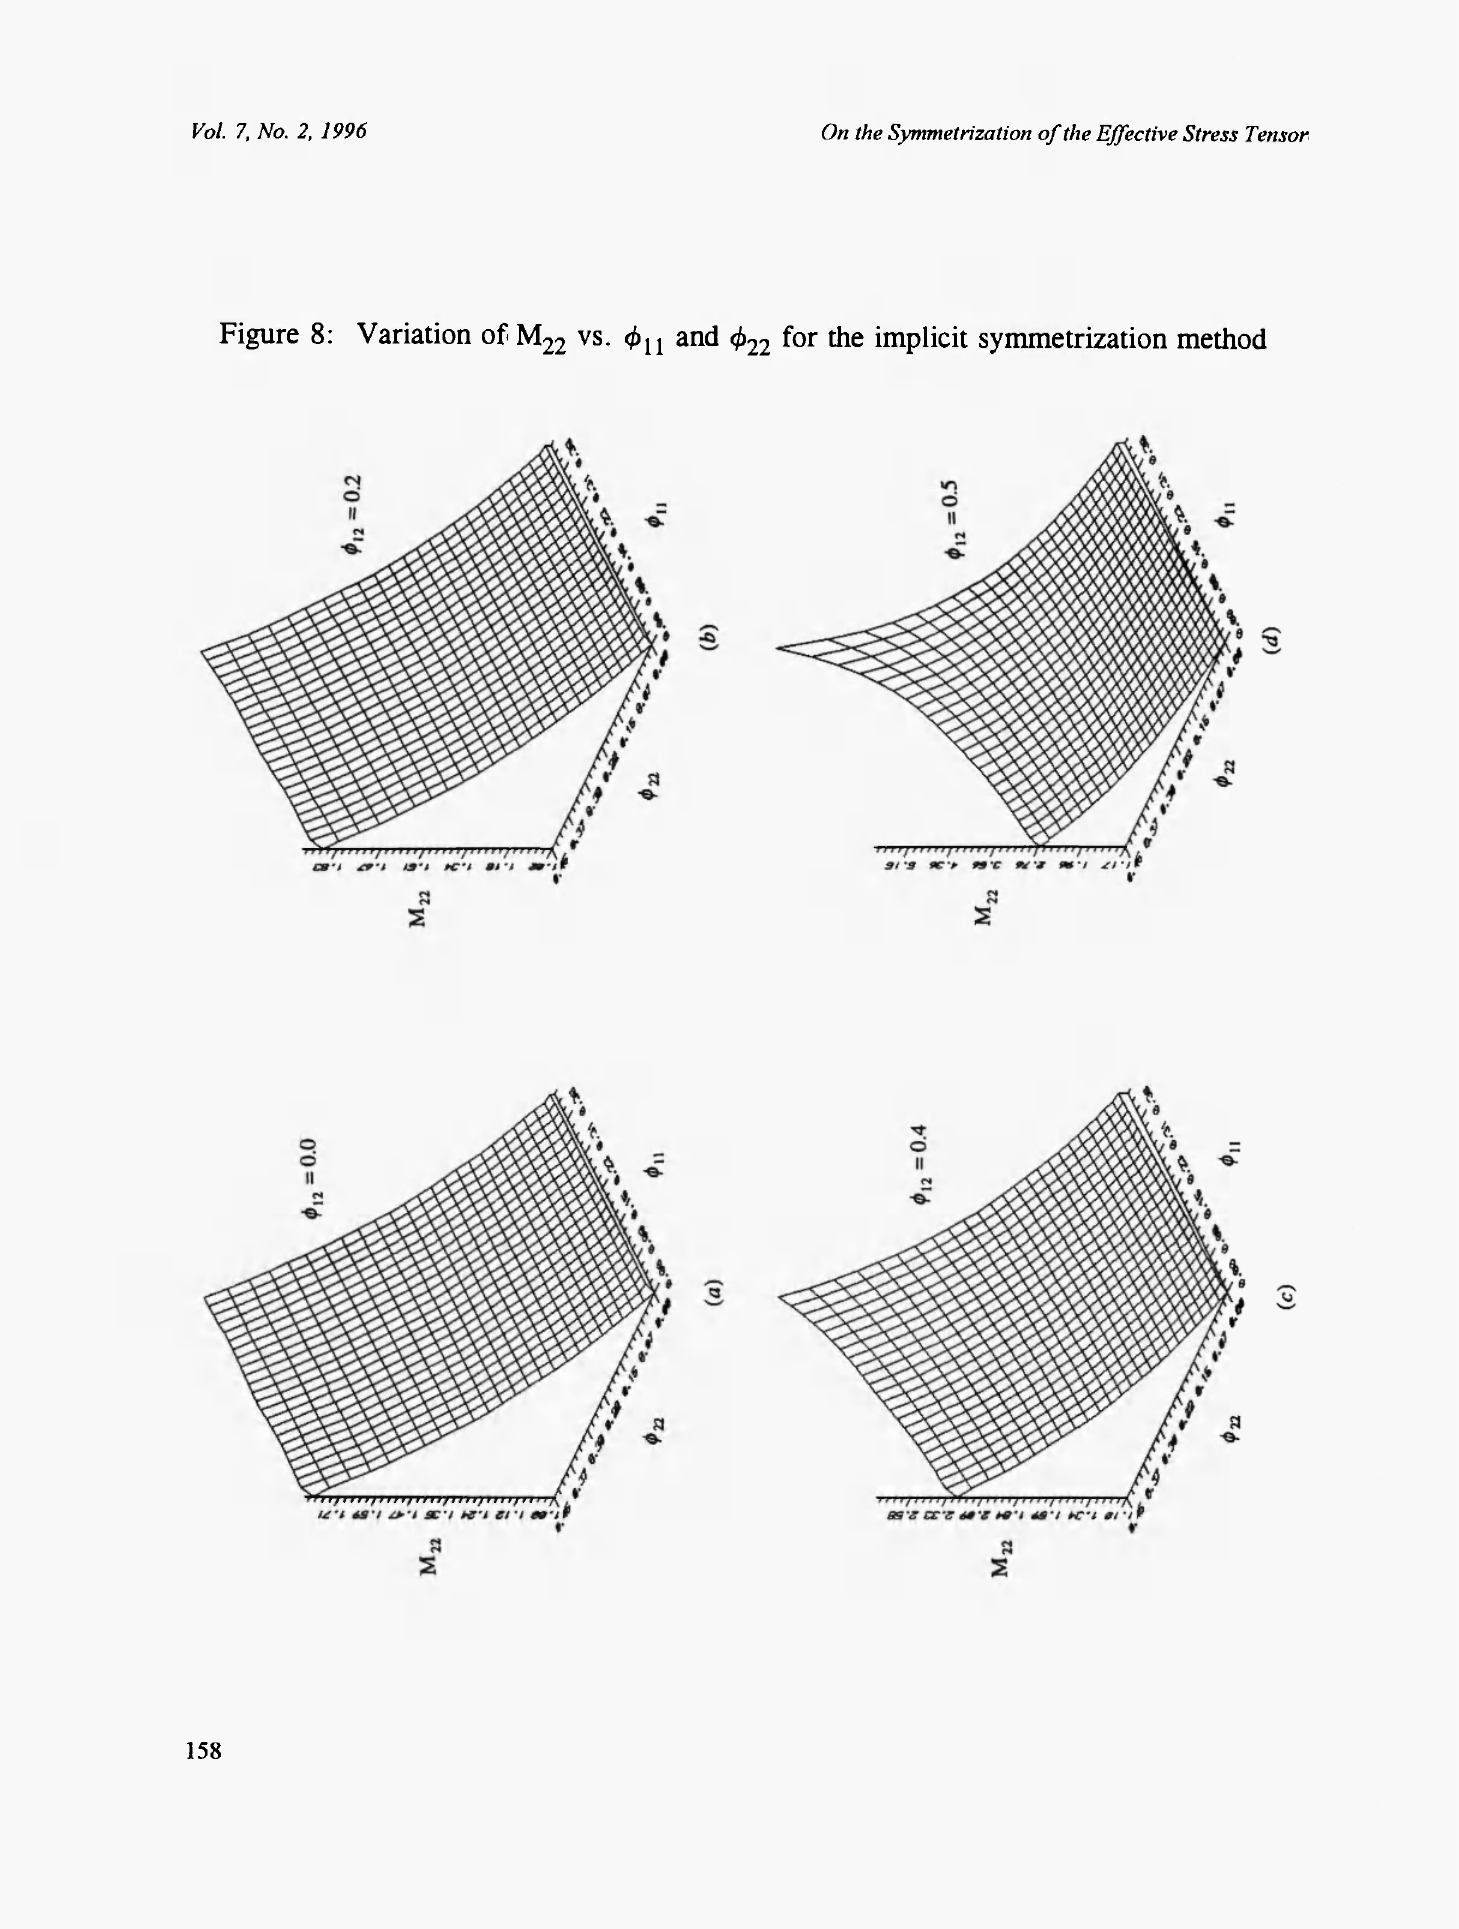
Figure 8: Variation of M